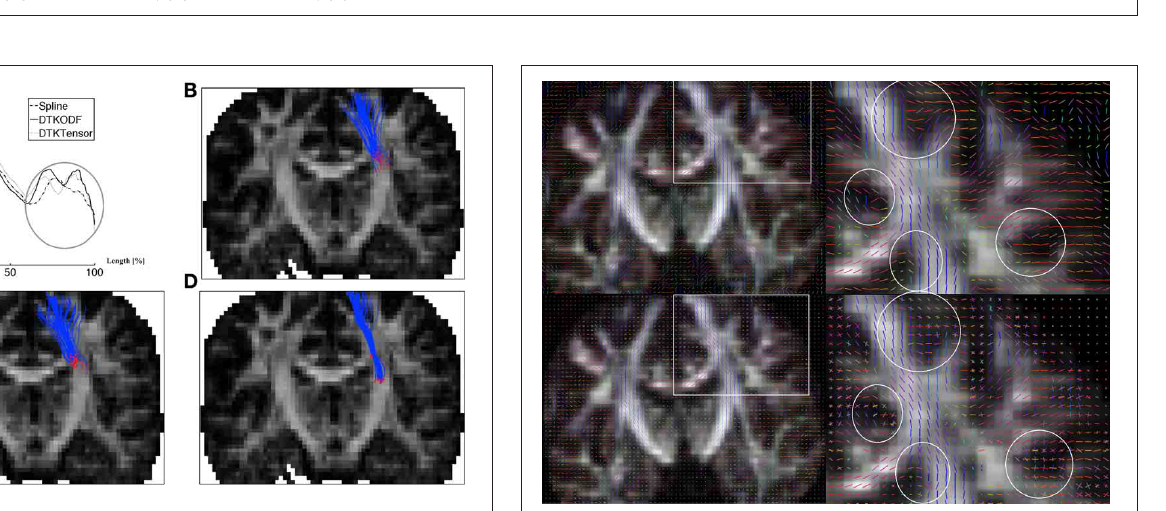
FIGURE 5 | Along-tract FA values obtained with the three methods: Spline , DTKODF , and DTKTensor . (A) CST —wave1, (B) CST —wave2, (C) CST —wave3, (D) Fminor —wave1, (E) Fminor —wave2, (F) Fminor —wave3.